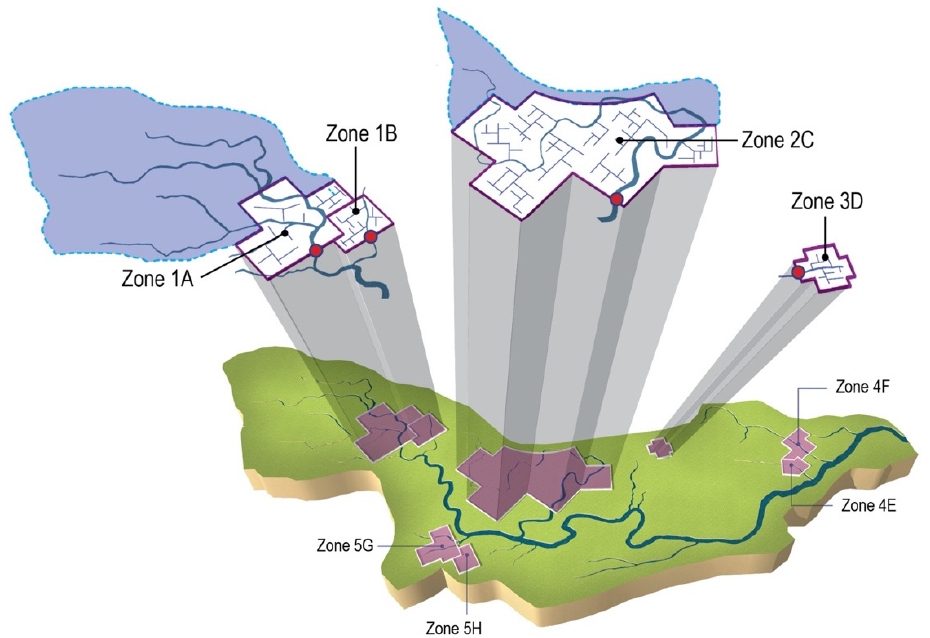
Figure 2. Here, eight SWM zones are identified according to their drainage areas associated with common outlets (shaded in purple). Properties within zones are spatially connected, with some having upstream contributing areas (e.g., zones 1A and 2C). Blue dotted lines represent drainage areas associated with different outlets, and upstream contributing areas are shaded in blue.